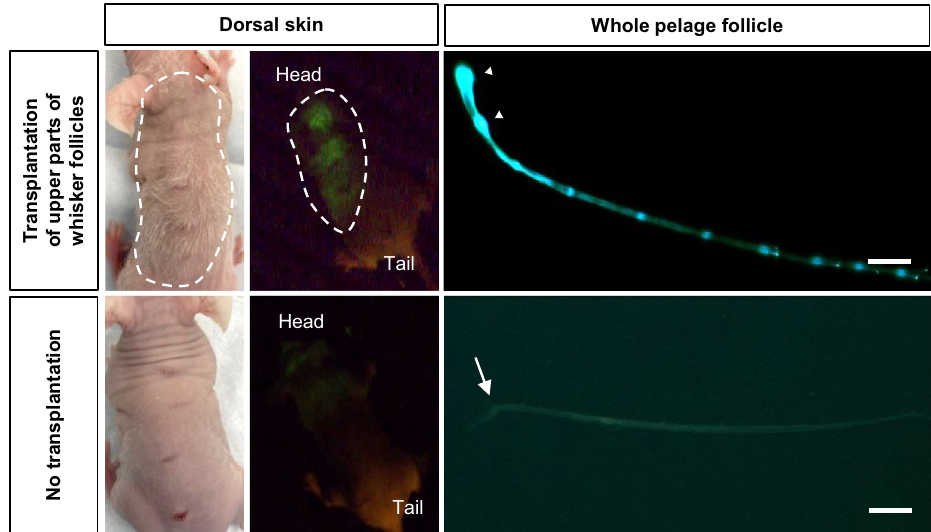
Figure 2. Location of HAP stem cells from the upper part of whisker follicles from ND-GFP mice in nude mice after transplantation. Fluorescence imaging of entire dorsal skin and pelage follicles of nude mice after transplantation of the upper part of whisker follicles from ND-GFP mice. White dotted line indicates hair growth area of the dorsal skin of nude mice. White arrowheads indicate HAP stem cells. White arrows indicate the twisted part of a pelage follicle. Scale bar = 100